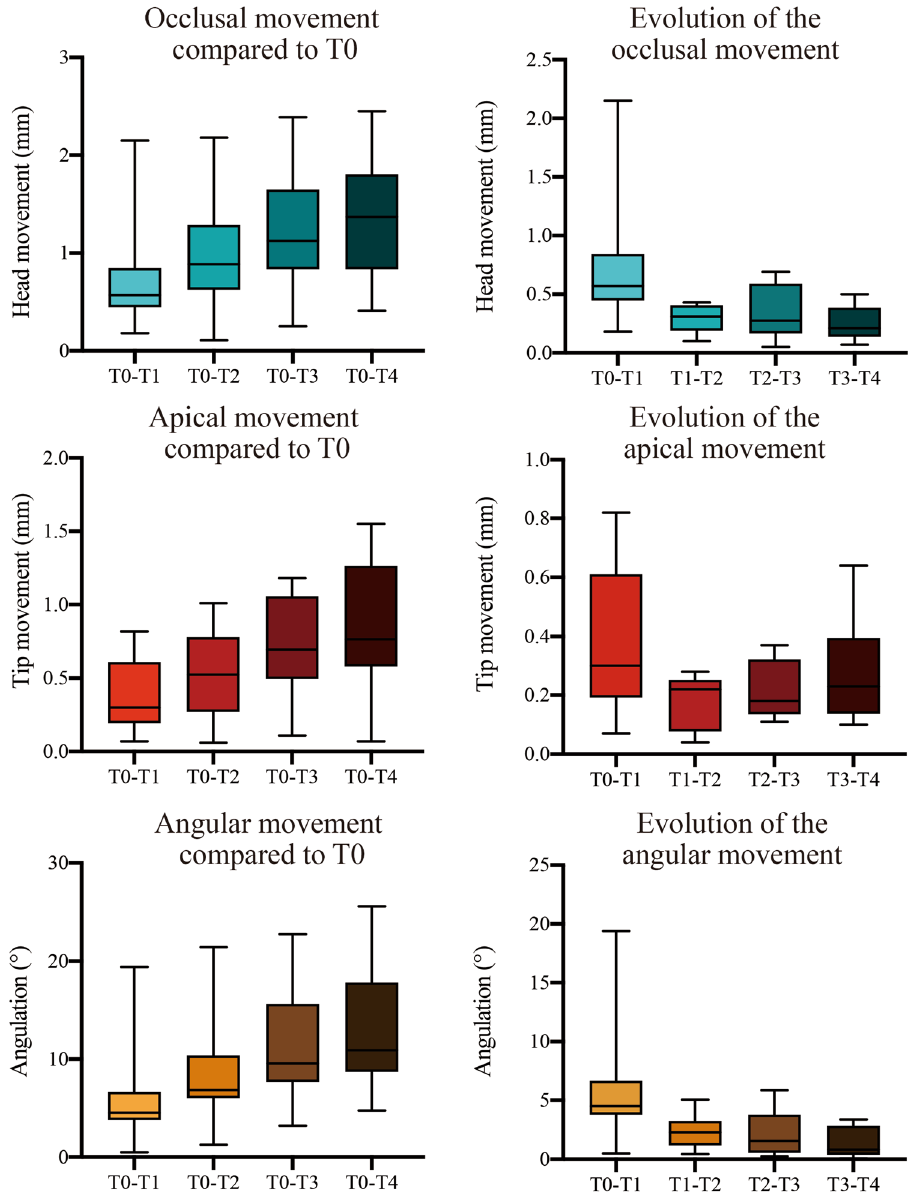
Figure 6. Mini-screw displacement. The displacement of the mini-screw was compared among different time points by Friedman test (n = 12). * P <